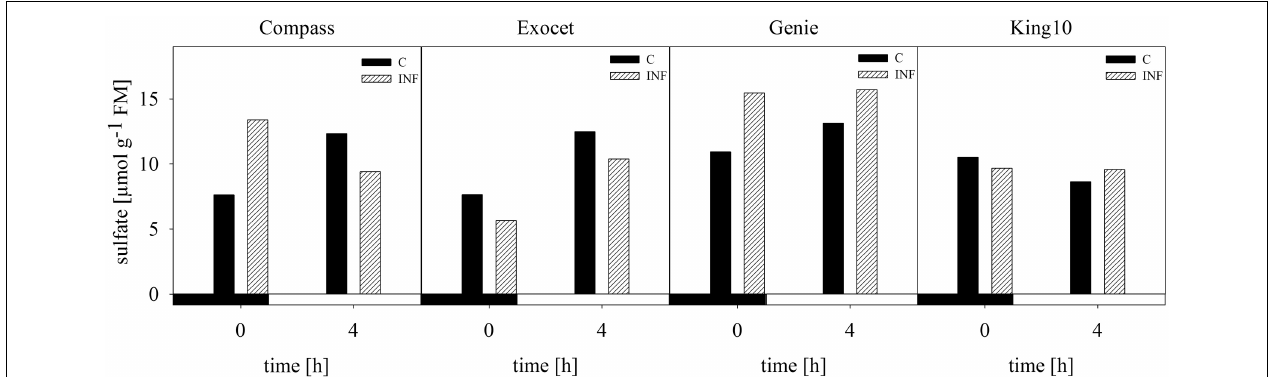
collected at 0 and 4h was used. Sulfate amount was calculated in µ mol g − 1 FM and data represent the result of one measurement. Filled bars represent the control plants (C) and striped bars indicate infected plants